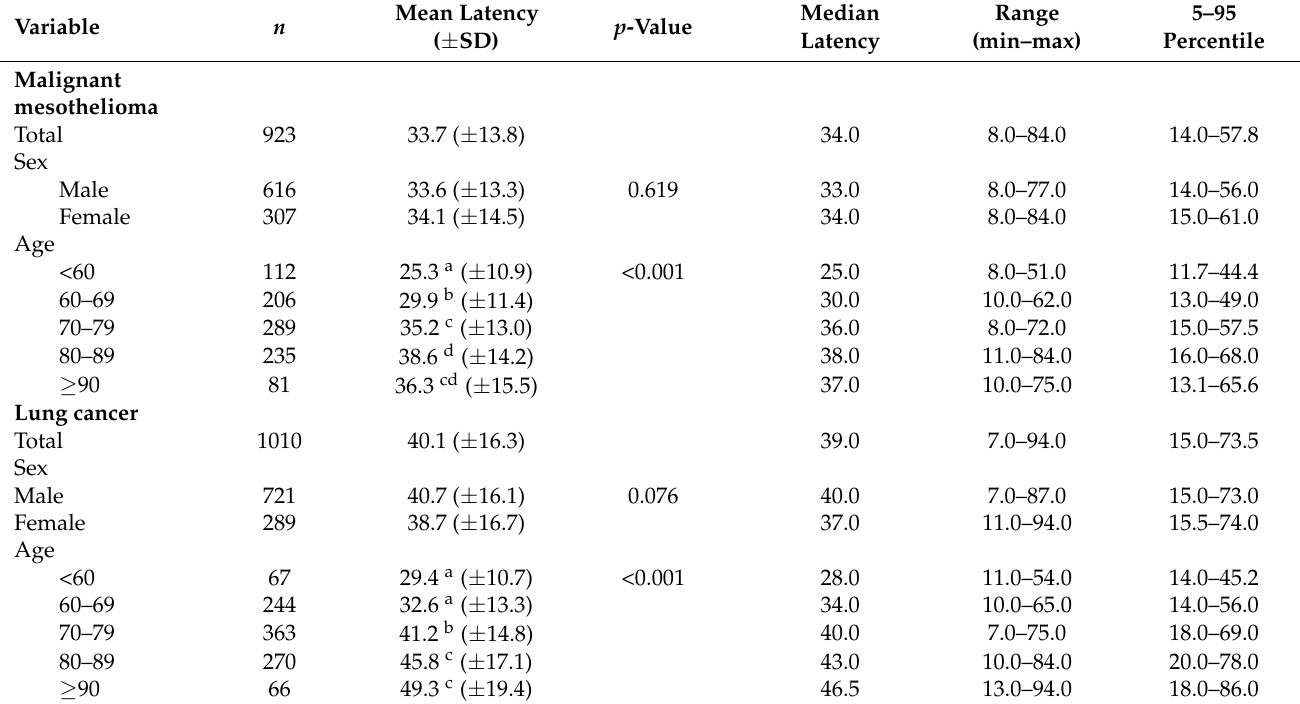
Table 2. Descriptive statistics on latency period of malignant mesothelioma and lung